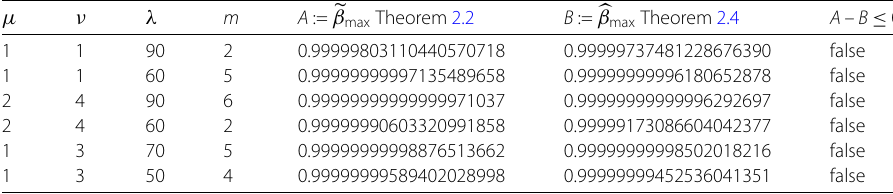
Table 2 Comparison of the order of convexity given by Theorems 2.2 and